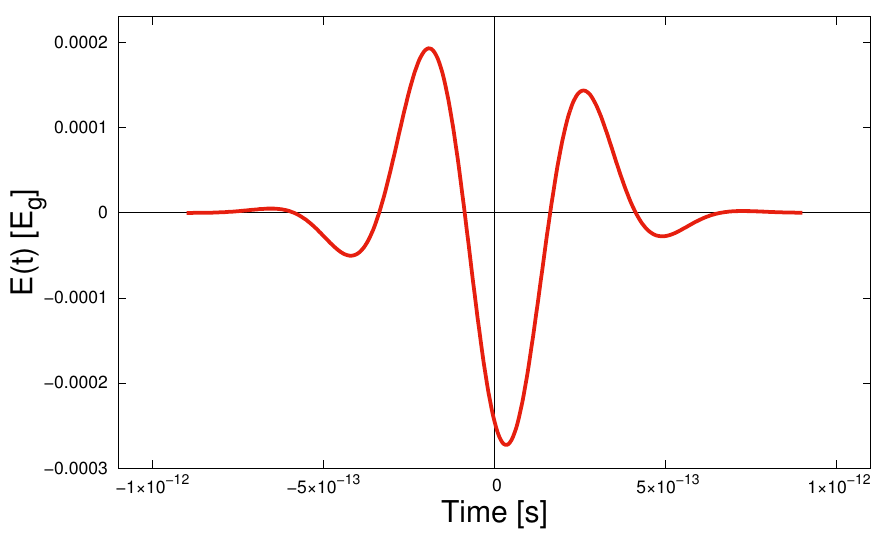
Figure 5. Time dependence of the field strength for the Gaussian envelope harmonic pulse (60) for E a = 3.0 V/ µ m, ω = 2 π